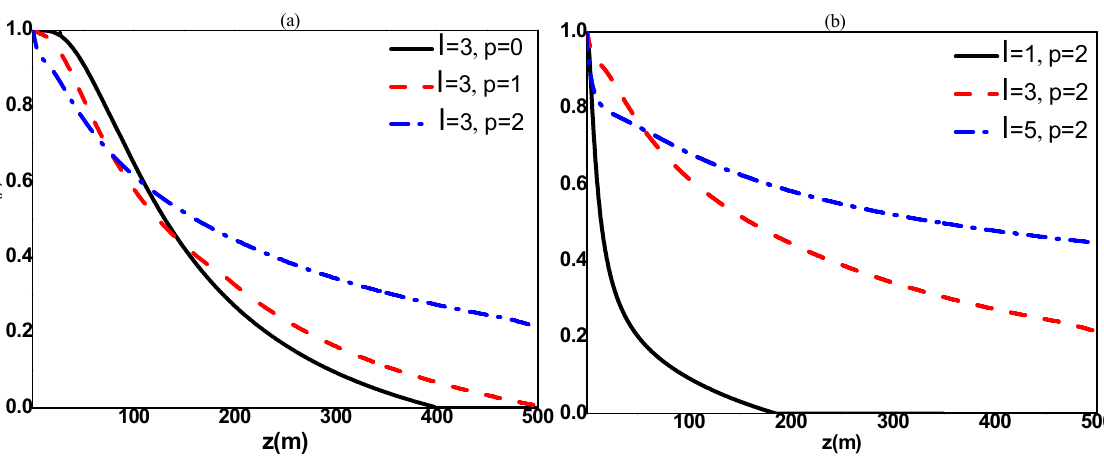
Figure 3. Concurrence versus propagation distance for different beam parameters. ( a ) For the different values of radial quantum number and ( b ) for the different values of azimuthal mode order.